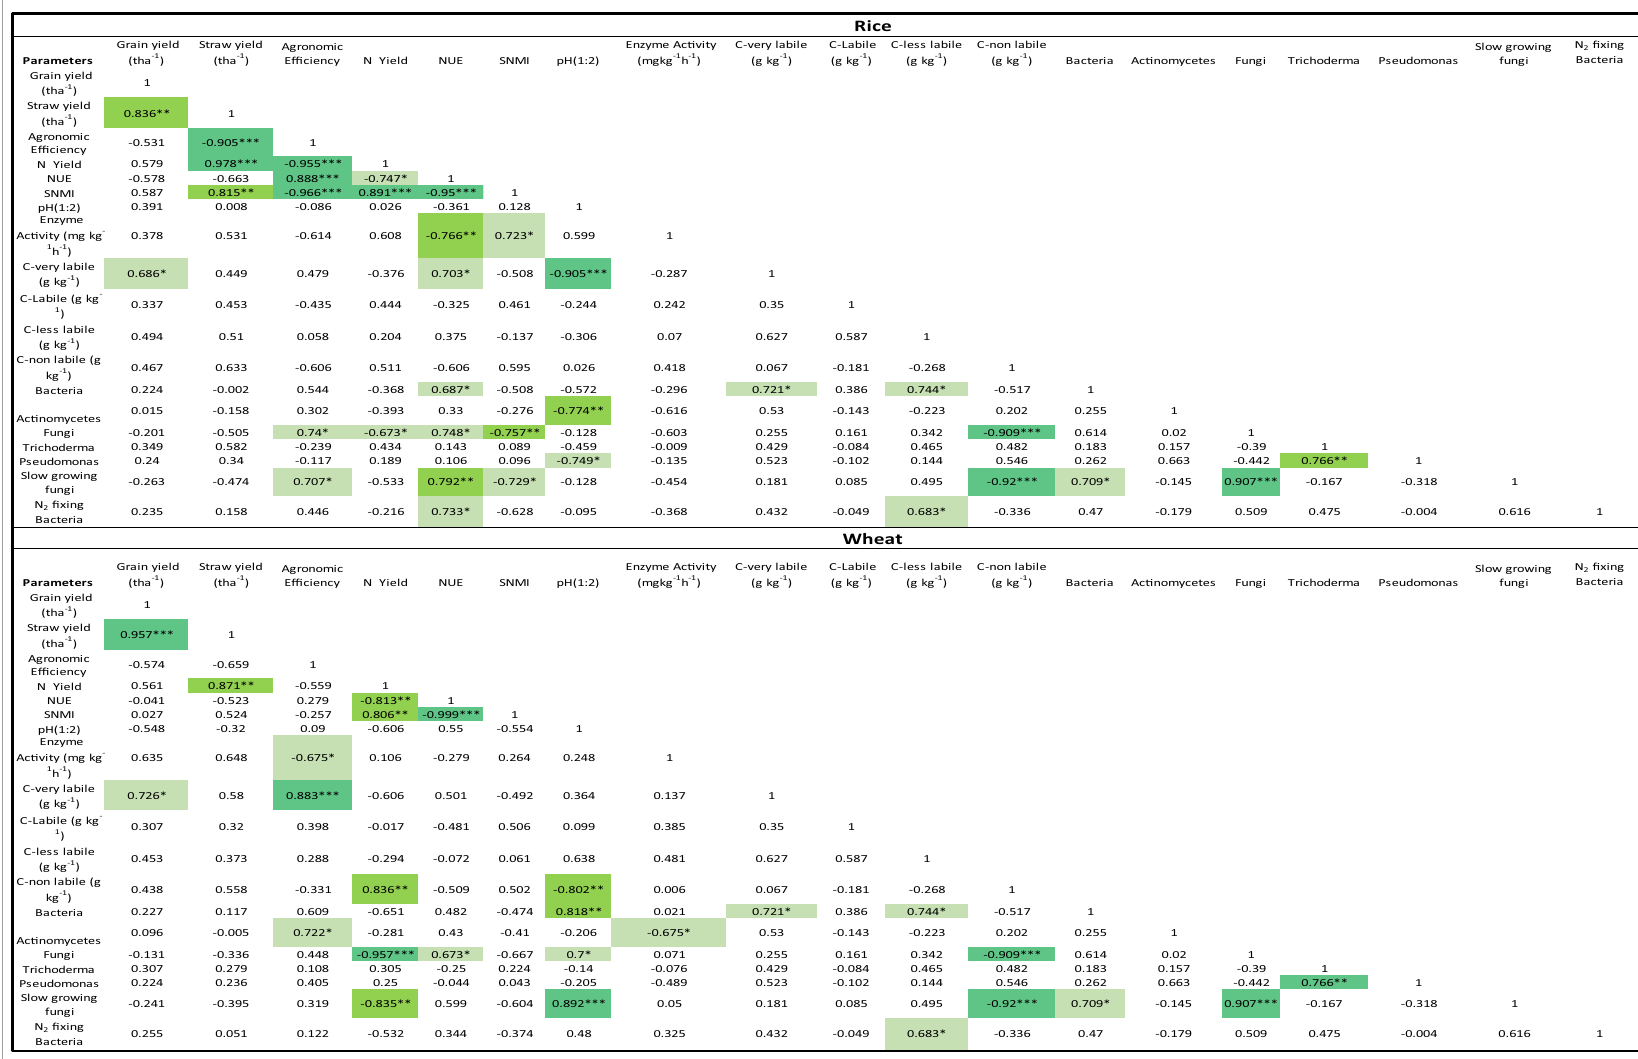
Slow growing fungi